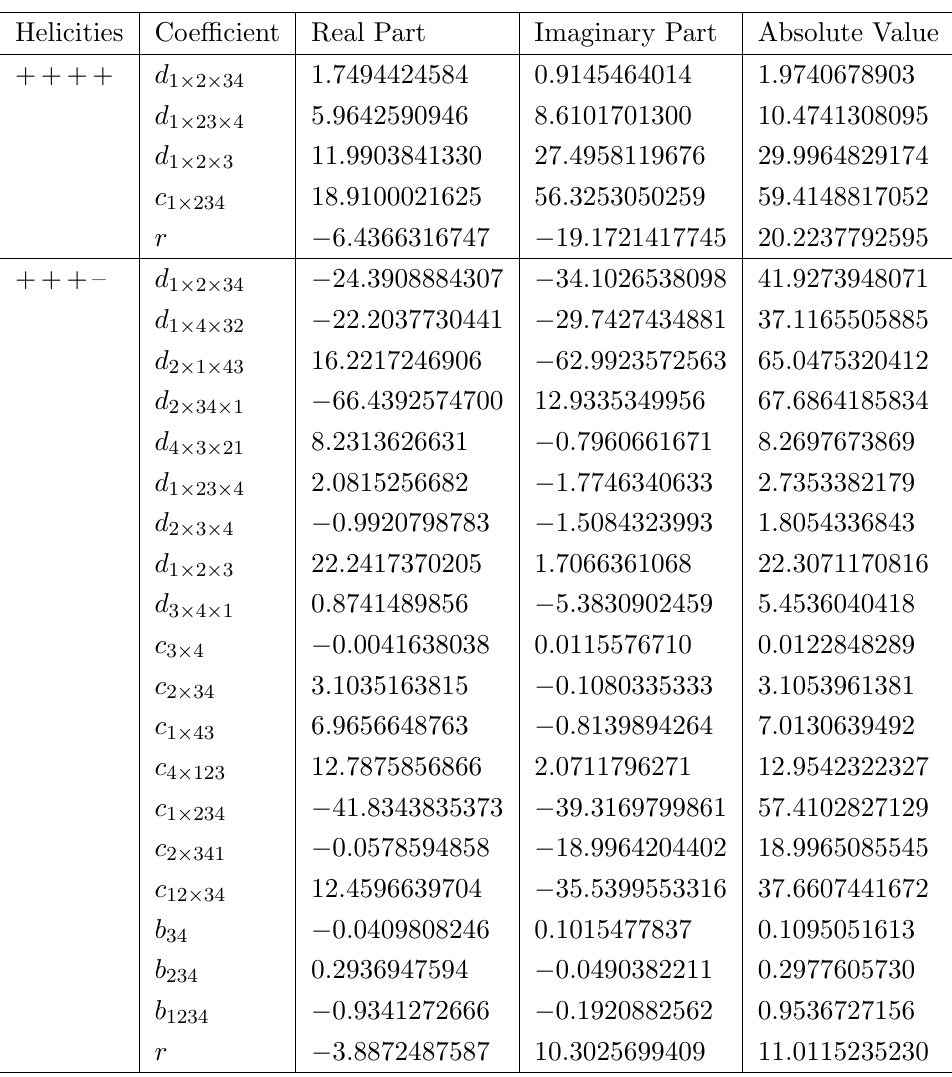
Table 6 . Numerical values of coe(cid:14)cients and rational terms for + + + + and + + + { helicities of of ggggh at kinematic point,